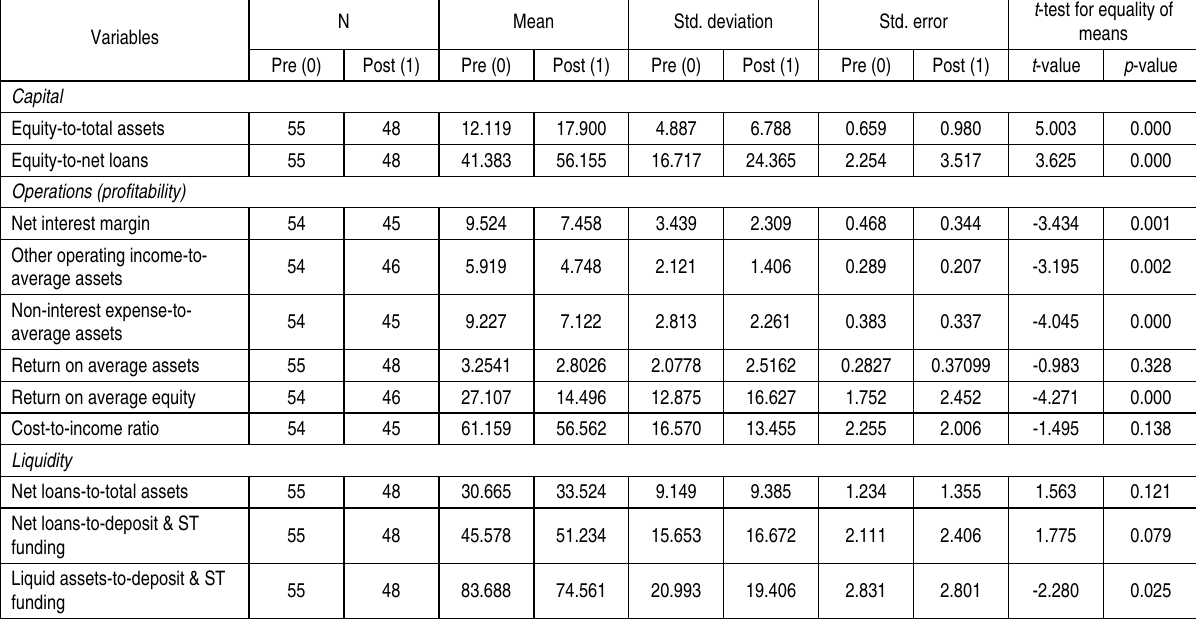
Table 2 (cont.). Descriptive statistics for the 15 banks pre- and post- M&A using financial ratios